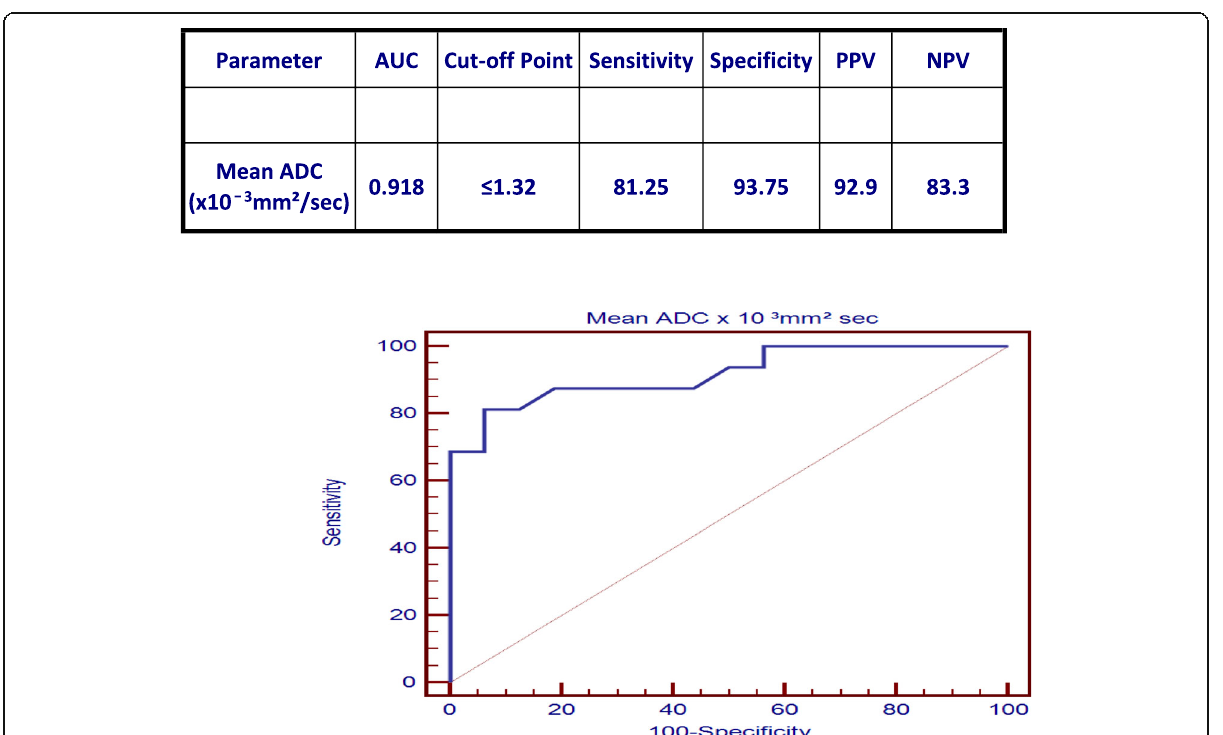
Fig. 2 ROC curve between control and patient group regarding mean ADC